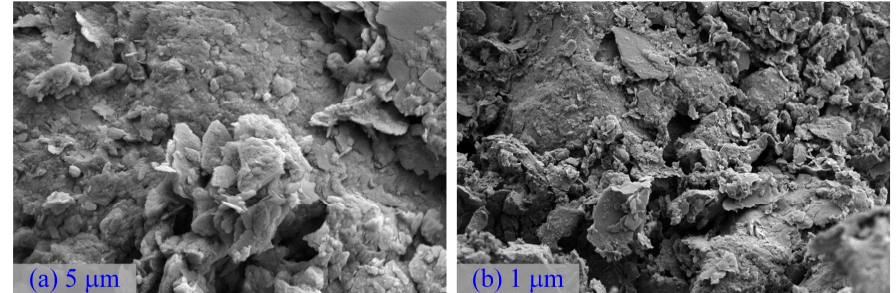
Figure 3. SEM images of DWS. ( a ) 2.0 KX ( b ) 10.0 KX.